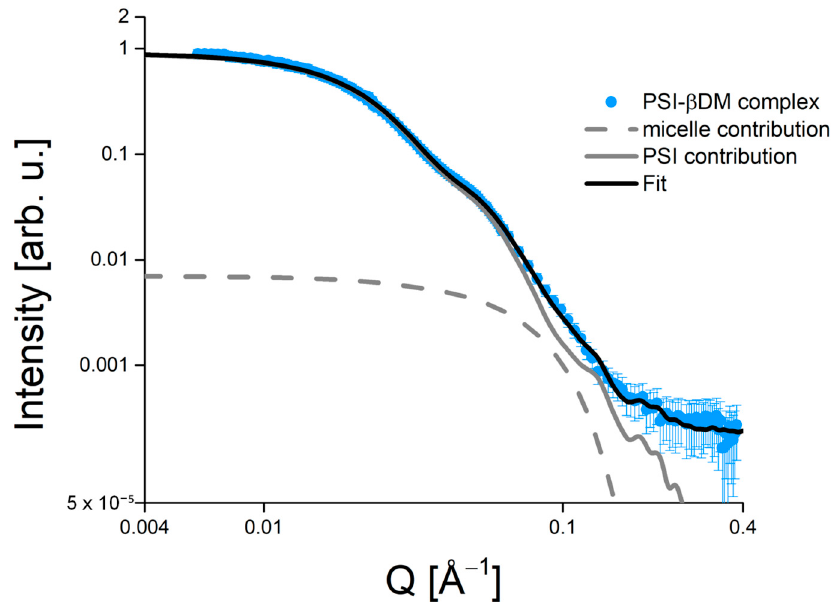
Figure 5. Fit of the PSI SANS data (blue points) measured at 100% D 2 O: The fit function (black line) is composed of (i) the reconstituted structure of the PSI trimer (gray line) and (ii) a contribution of free β DM vesicles (dotted gray line).